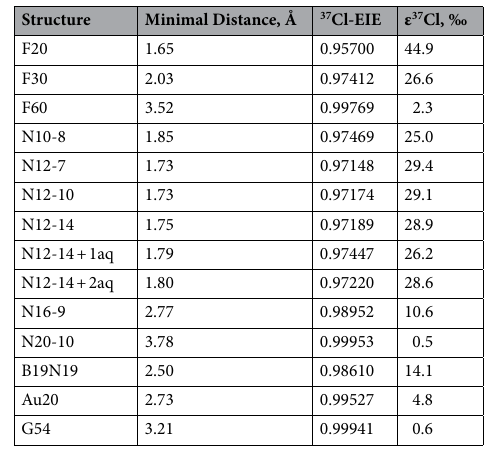
Table 1. Minimal X-Cl (X = C, N, B, or Au) distances, equilibrium isotope effects and isotopic